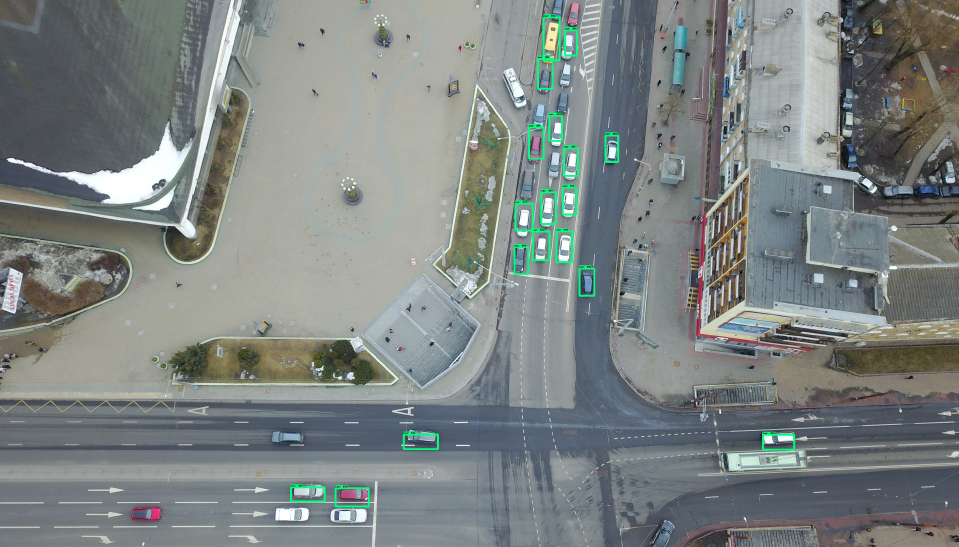
Figure 12. Example of Faster R-CNN misclassifications on an image of the PSU (Prince Sultan University) dataset, showing several false negatives (non-detected